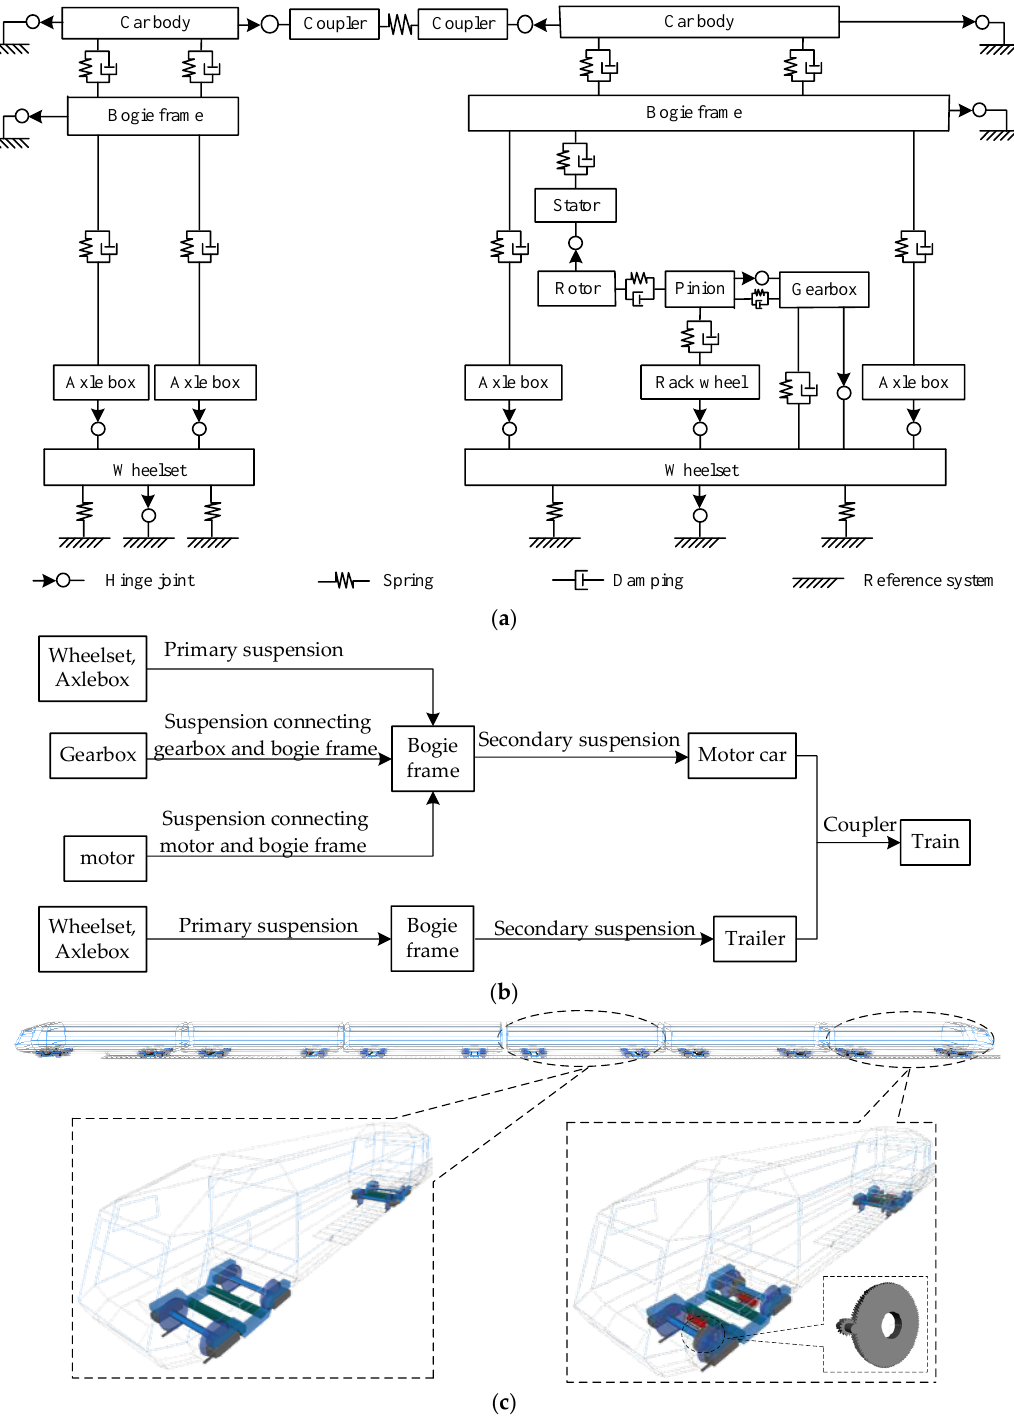
Figure 1. Marshaling urban rail train dynamics model with the traction transmission system: ( a ) Topology model of the urban rail train; ( b ) The modeling flow chart of the marshaling urban rail train; ( c ) The marshaling urban rail train dynamics model.